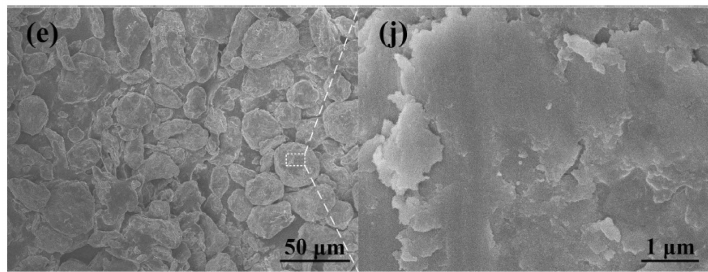
Figure 2. FESEM micrographs of CNT/Al (with powder size of 20 µ m) mixture ball milled for ( a ) 3 h, ( b ) 6 h, ( c ) 12 h, ( d ) 18 h and ( e ) 24 h. From ( f ) to ( j ) are the magnified images of the white dotted regions in ( a – e ),